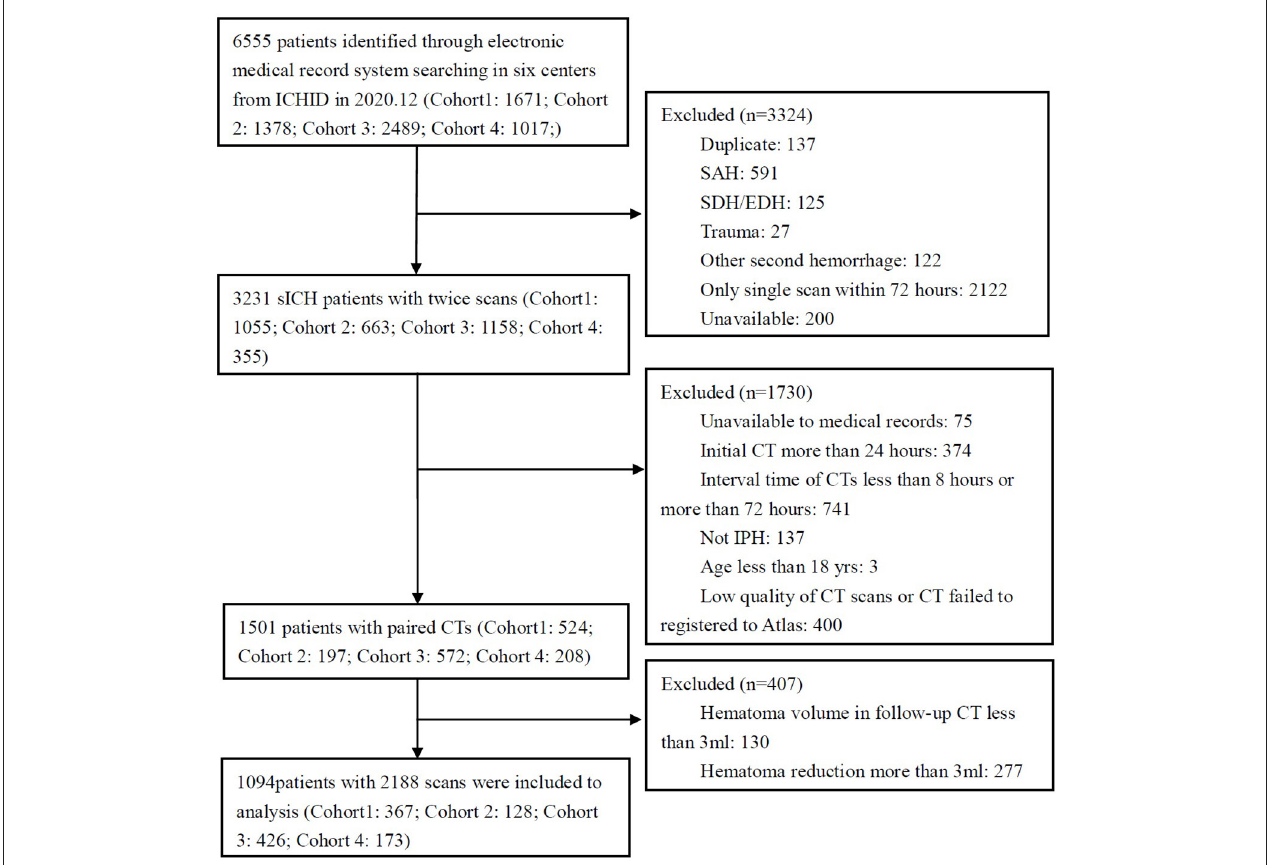
FIGURE 1 | Flowchart of patient selection.